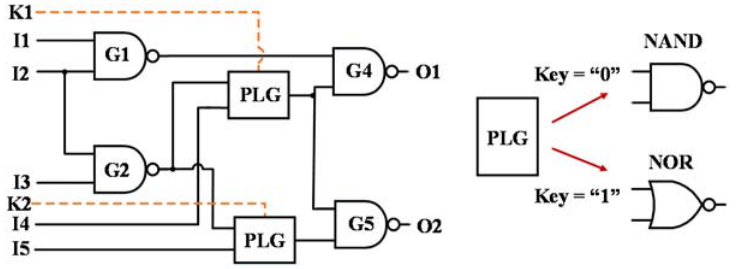
Figure 49. Encrypted ISCAS circuit with NAND/NOR polymorphic gates.